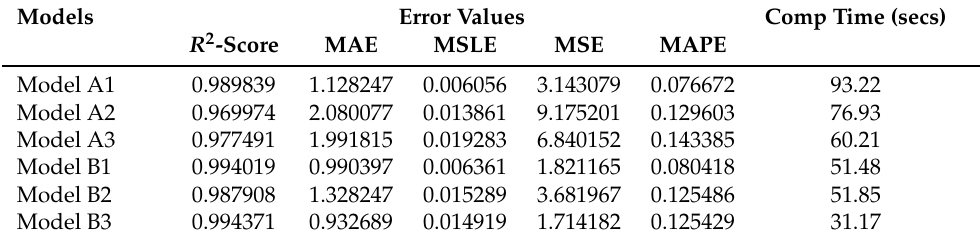
Table 7. Error values and computation time for various NN models.